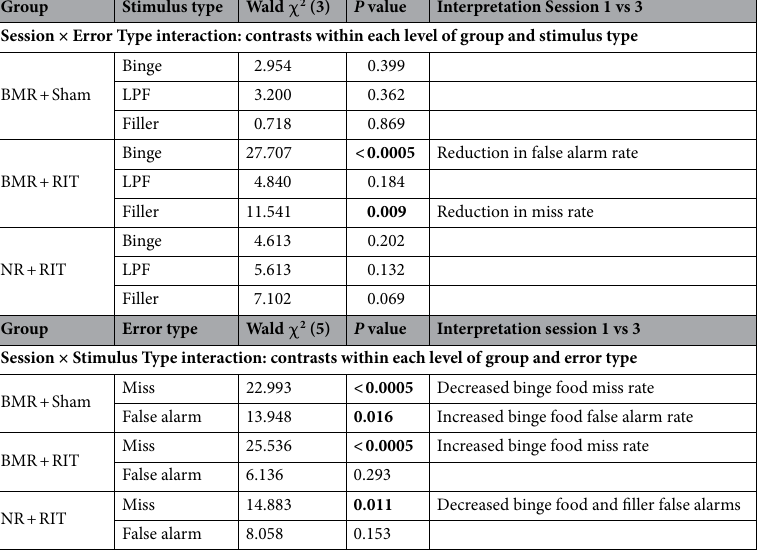
Table 2. Simple effects analyses for interpretation of 2 way Stimulus × Error Type and Session × Stimulus Type interactions. P values are sequential Bonferroni-corrected. Significant values are in bold.